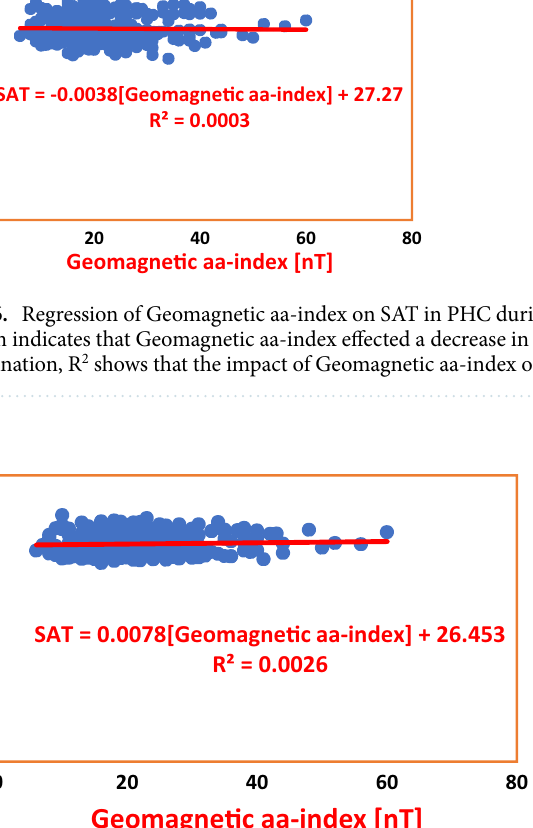
SAT = 0.0078[Geomagne(cid:31)c aa-index] + 26.453